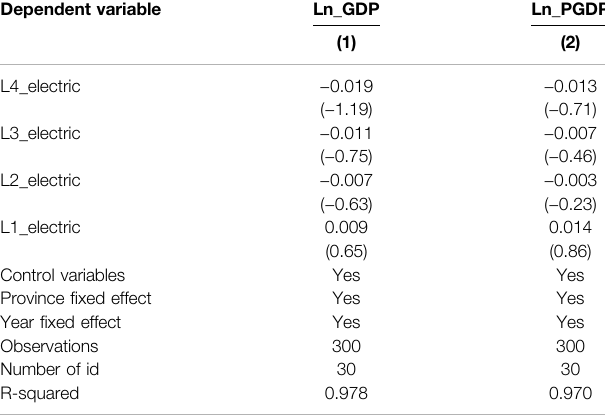
TABLE 4 | The counterfactual check regression